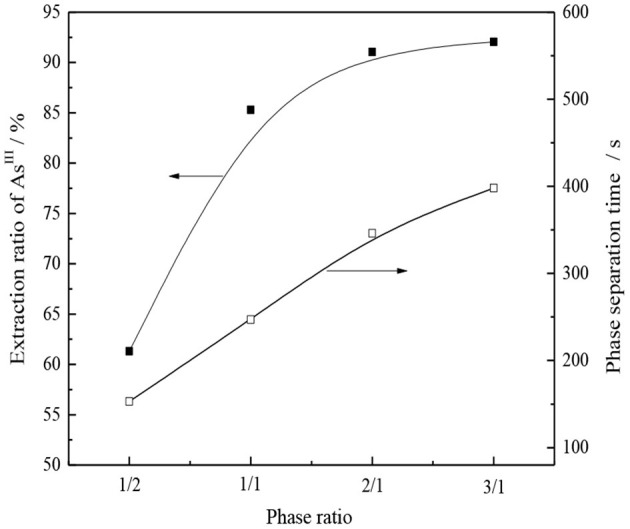
Effect of phase ratio on AsIII extraction and phase separation.